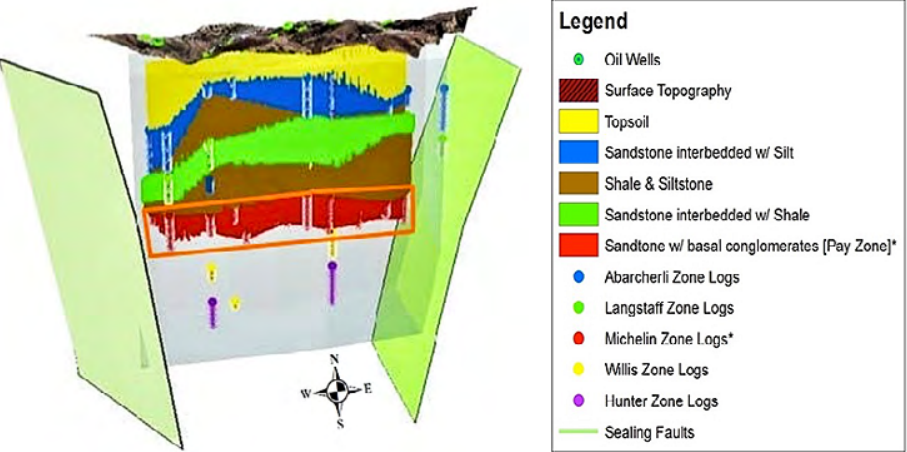
Figure 6. 3D Well Log Stratigraphic Digitization Model. Orange box depicts study area reservoir illustrating the boundaries for all interpolated and simulated models (seen in Figures